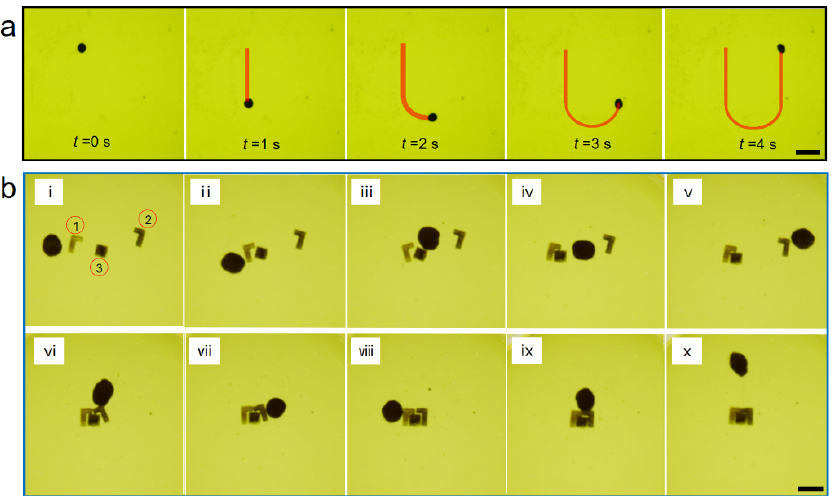
Figure 4. Trajectory manipulation of a magnetic microswarm and the precise microassembly of ‘Tetris’ microparts. ( a ) The disk-like microswarm under the programming magnetic fields. The scale bar is 800 μ m. ( b ) A complete assembly of the distributed ‘Tetris’ microparts under the manipulation of a swarm. Figures i–vii show that the three blocks are preliminarily assembled. Then, in figures viii–x, the small gaps between blocks are eliminated by pushing the assembly gently on the left and top sides. The scale bar is 1 mm.